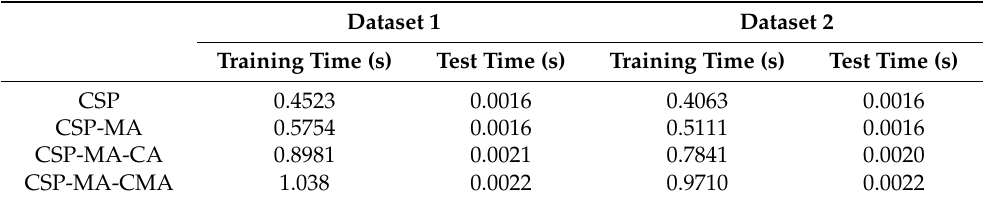
Table 6. Average time cost (s) using different alignment